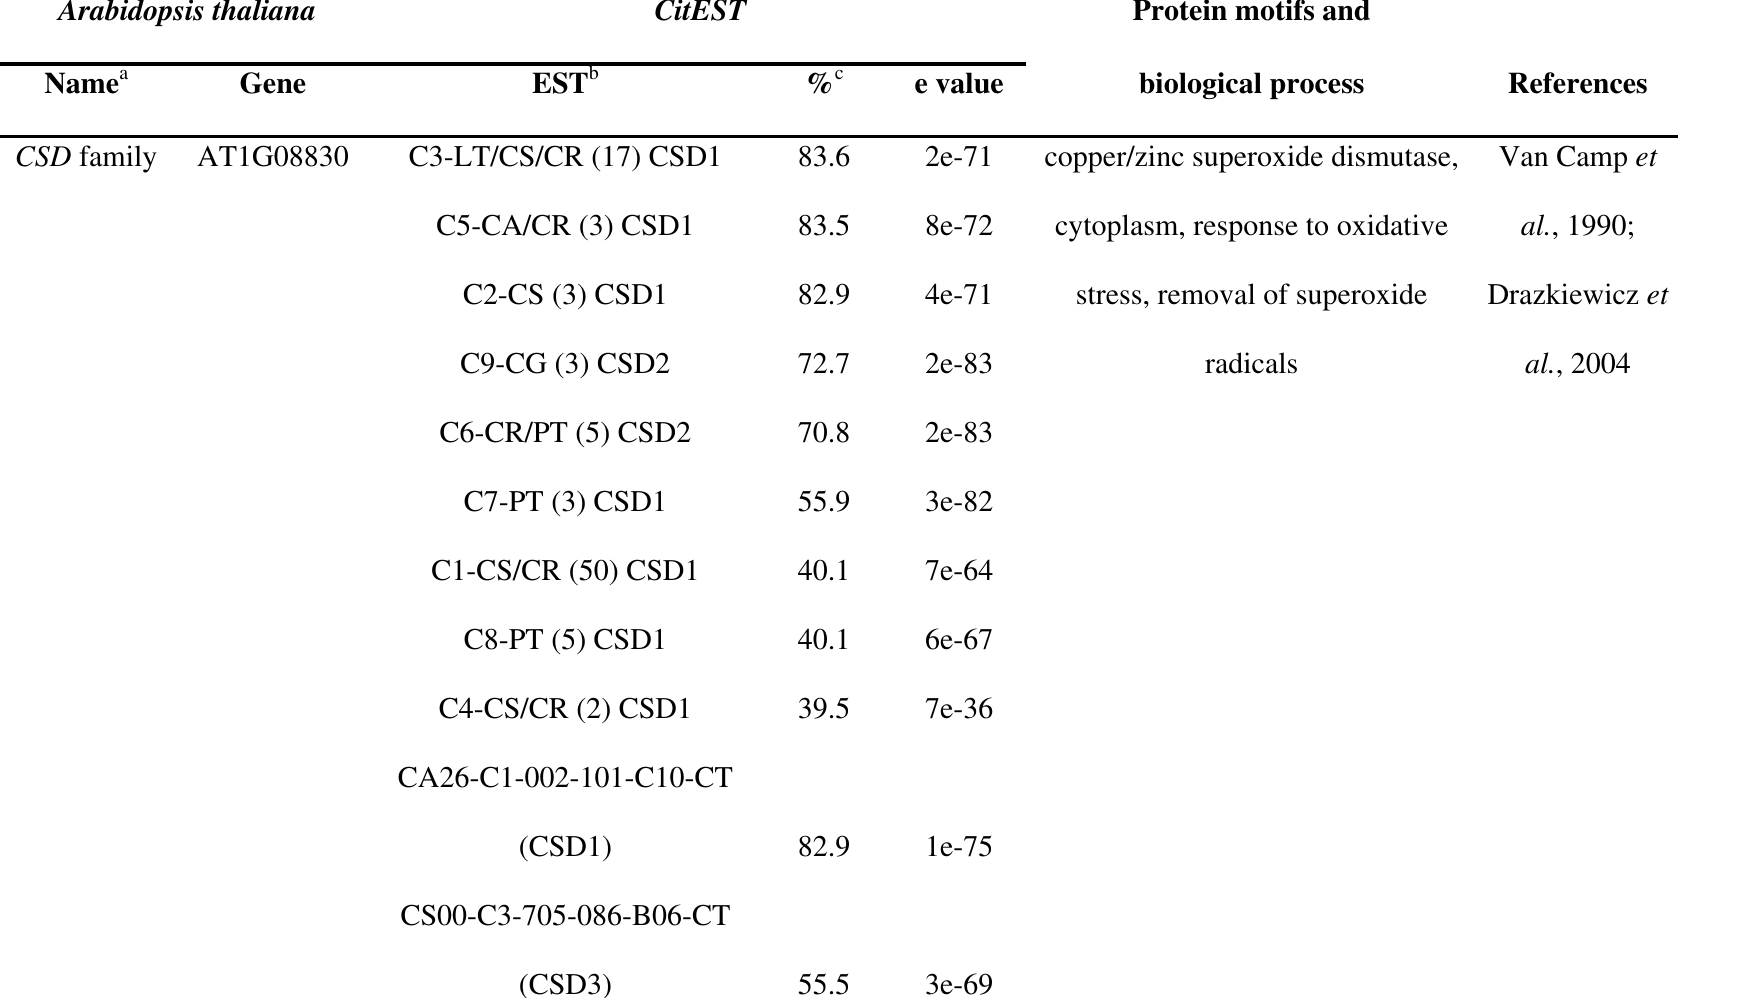
Table S7 – Citrus ESTs with homology to superoxide dismutase protein families from Arabidopsis thaliana